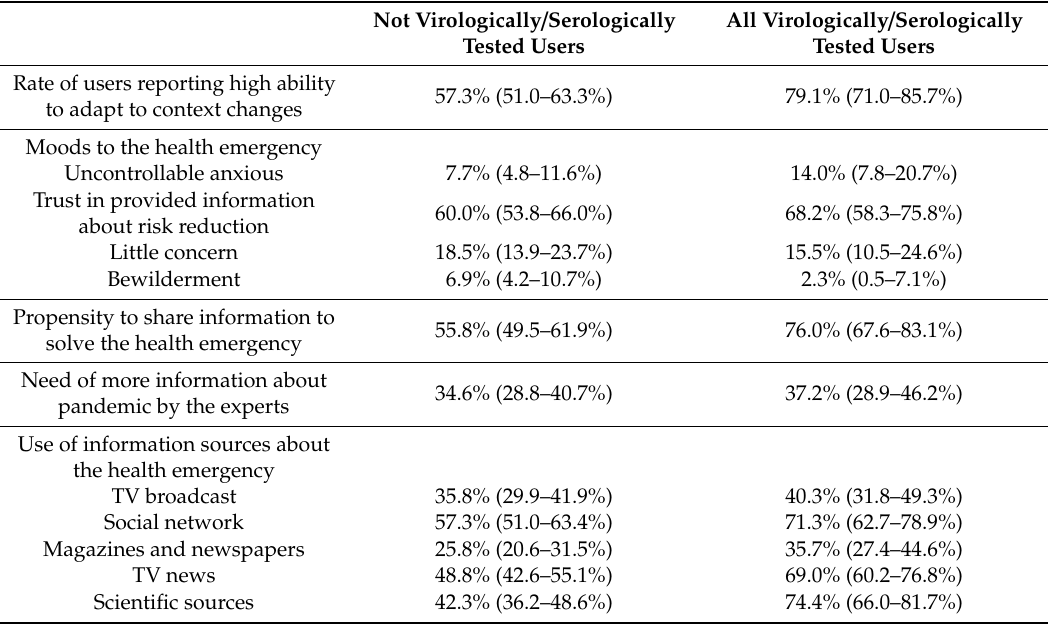
Table 3. Dress-COV: frequency (95% CI) of some psychological aspects and use of informative sources between tested and not tested